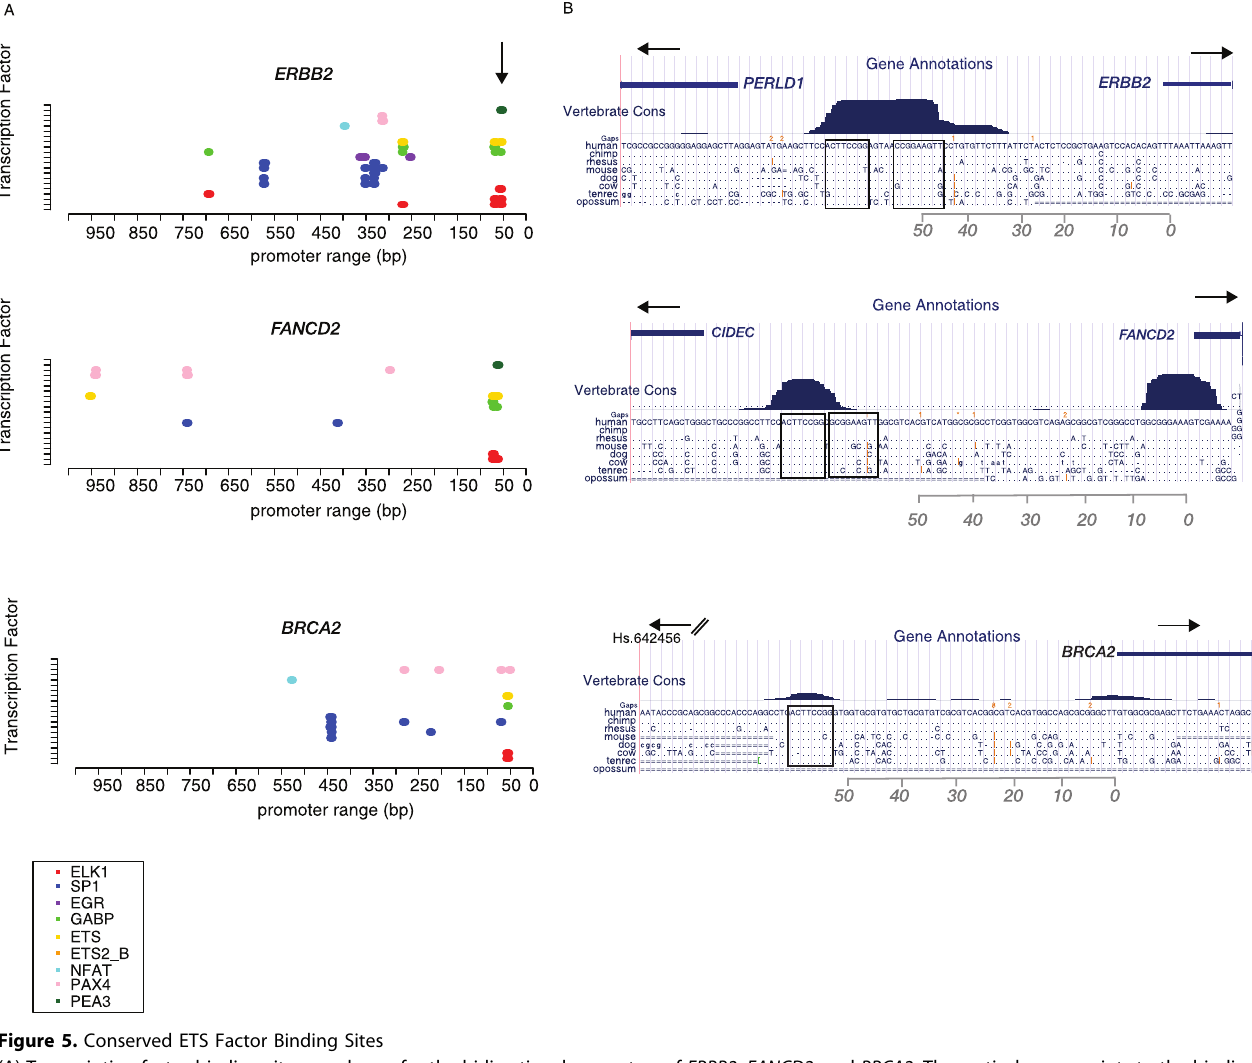
Figure 5. Conserved ETS Factor Binding Sites (A) Transcription factor-binding sites are shown for the bidirectional promoters of ERBB2, FANCD2, and BRCA2 . The vertical arrow points to the binding site preferred by the ETS factor family member ELK1. The legend indicates the identity of all binding sites. (B) The sequence level view of these ETS factor binding sites are shown as snapshots from the UCSC Human Genome Browser. Horizontal arrows indicate the direction of transcription. Position 0 in (A) corresponds to the transcription start site of the cancer genes in (B). The annotation track labeled ‘‘ Vertebrate Cons ’’ represents the multiple-sequence alignment and conservation track for the eight-way vertebrate genome comparison at the UCSC Human Genome Browser. The putative ELK1-recognition sequences are boxed. The partner to BRCA2 is not within the range